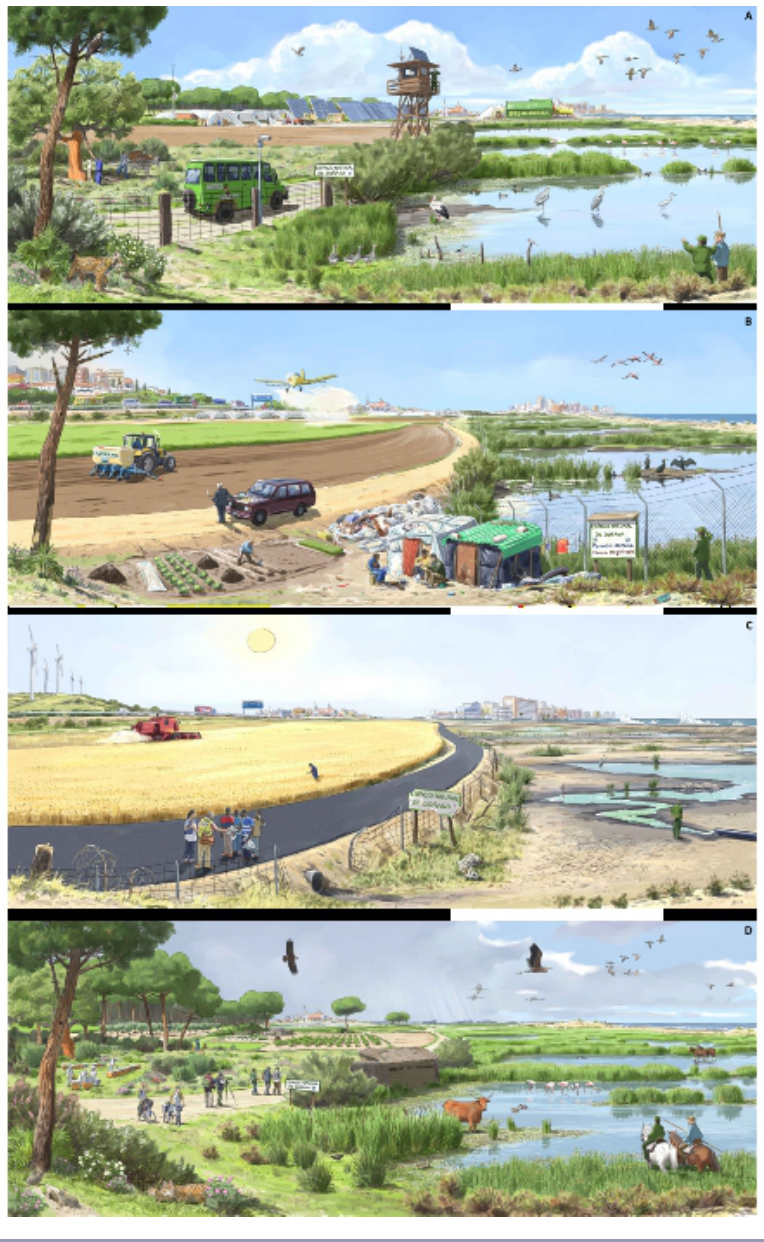
Fig. 4 . The four scenarios of the Doñana social-ecological system, illustrating the main characteristics of each scenario and the main land uses. (A) Doñana – Global Knowledge features the evolution and implementation of technologies in the Doñana social-ecological system; (B) Doñana Trademark results in intensified agriculture and tourism, as well as social conflicts; (C) Arid Doñana has a lack of water due to climate change, and features the efforts of NGOs to maintain social cohesion; and (D) Adaptive Doñana – Wet and Creative shows a mosaic of uses compatible with sustainability. Feedback between the illustrator and the authors was needed to achieve the final results. Illustration by Antonio